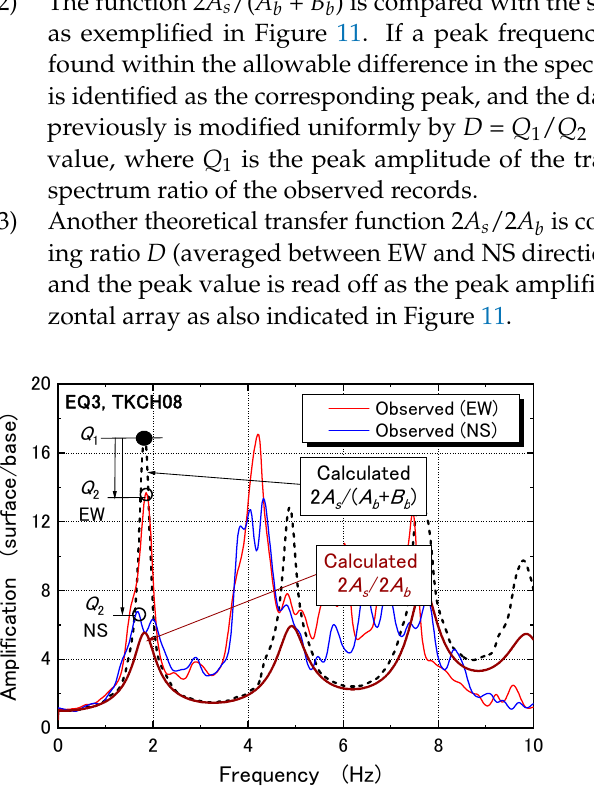
a solid straight line on the chart.